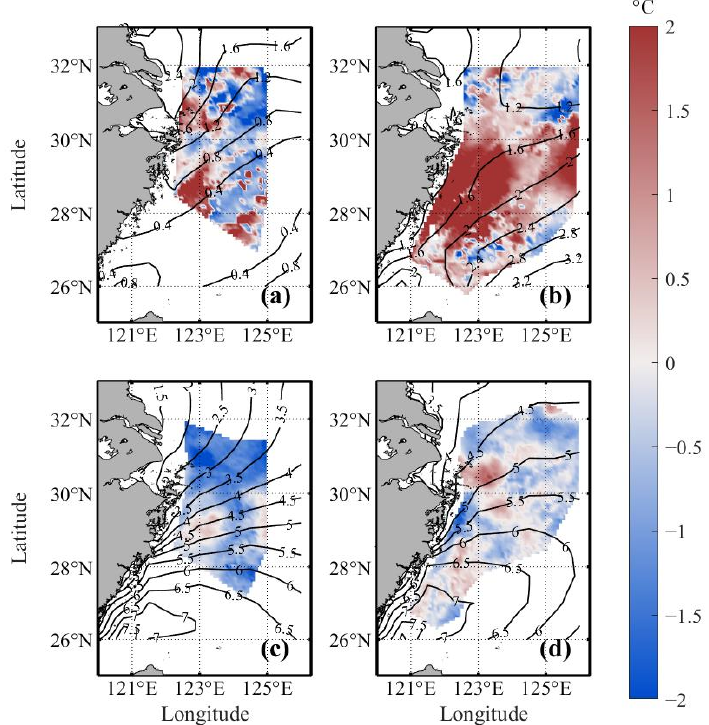
Figure 15. The pictures of bias between the interpolated SST and the satellite derived SST together with the contour maps of the wind speed. ( a ) Summer 2010; ( b ) Summer 2011; ( c ) Autumn 2010; and ( d ) Autumn 2011.